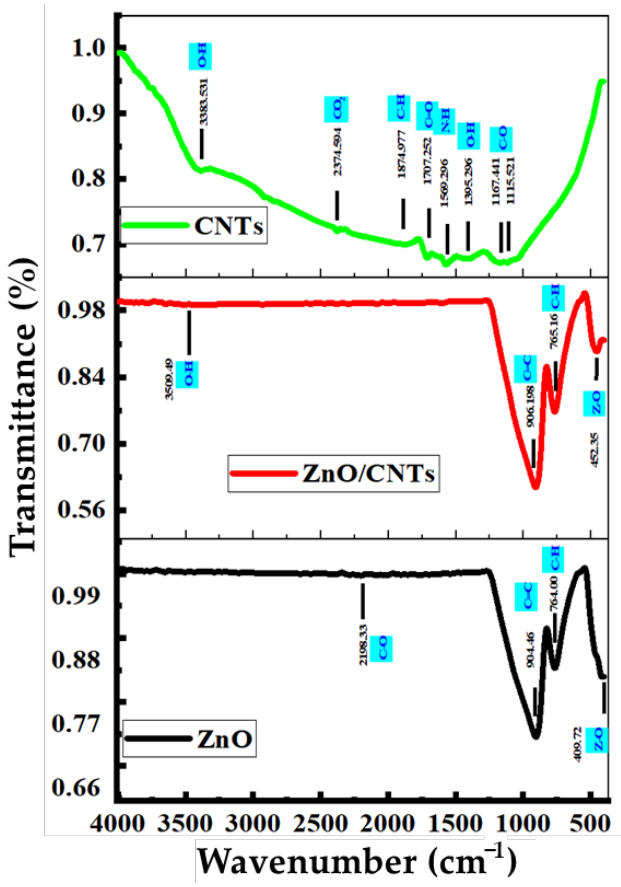
Figure 4. FTIR spectra for ZnO, CNTs, and ZnO/CNTs samples.